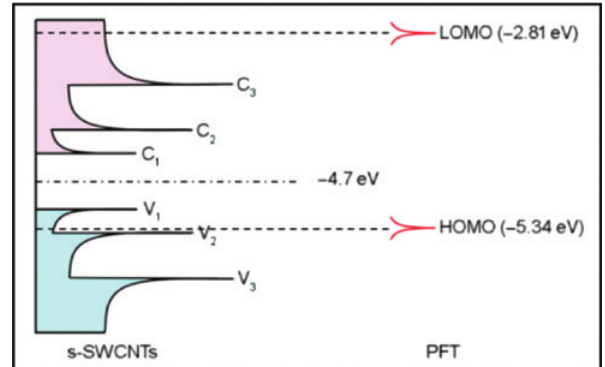
Figure 4: Energy diagram of HOMO and LUMO levels for PFT and